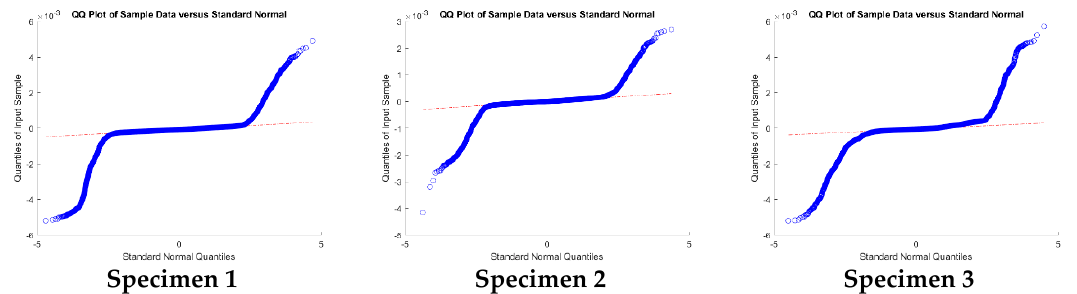
Figure 8. Q-Q plots of relative discrepancies between the macro and zoom lenses reconstruction for the separator (specimen 1), the brooch (specimen 2), and the racloir (specimen 3).